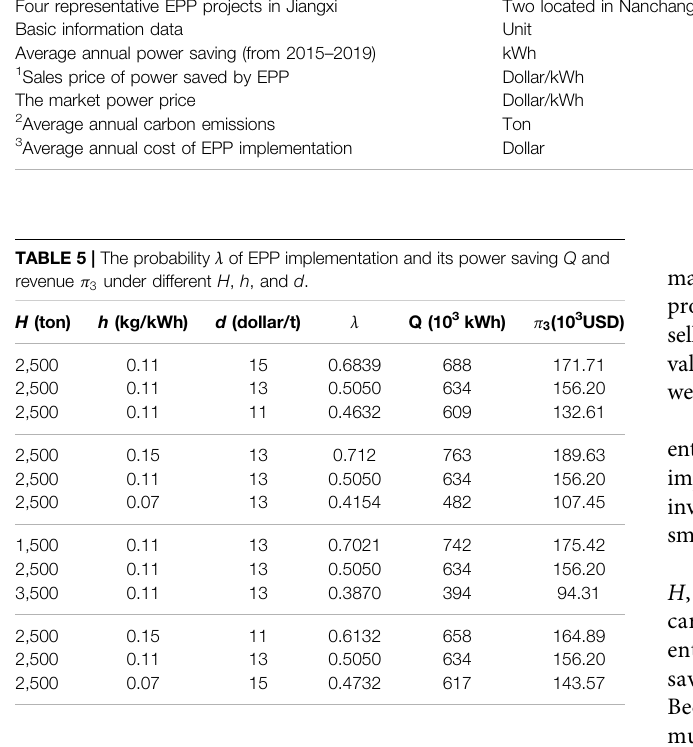
TABLE 4 | The survey object descriptions and fi xed parameter setting. Respondents Description Remark Four representative EPP projects in Jiangxi